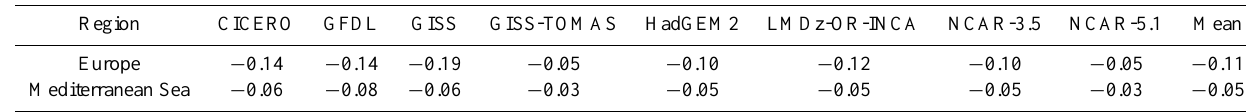
b). This is also visible for the overestimation of MERIS over 1105 the European continent (Figure 13 a). However AVHRR and LMDz-OR-INCA present the same decrease in AOD from the early 1980s likely due to the decrease in European sulfate emissions. The high AOD value obtained in 1992 visible in MVIRI, AVHRR and TOMS is probably linked to the vol- 1110 canic eruption of Pinatubo: Moulin et al. (1997b) estimate a possible bias as high as +0.04 for summer 1992. More generally, caution must be used with long aerosol time se- ries such as retrieved from AVHRR and MVIRI, as the sen- sors have been used on different platforms during the period. 1115 Breaks in the time series can be linked to problems in cross- calibration (Moulin et al., 1996). Figure 14 illustrates the issue for MVIRI data. It shows the difference in monthly mean AOD from June 1983 to Decembre 1997, compared to the monthly average on the whole period. Changes in satel- 1120